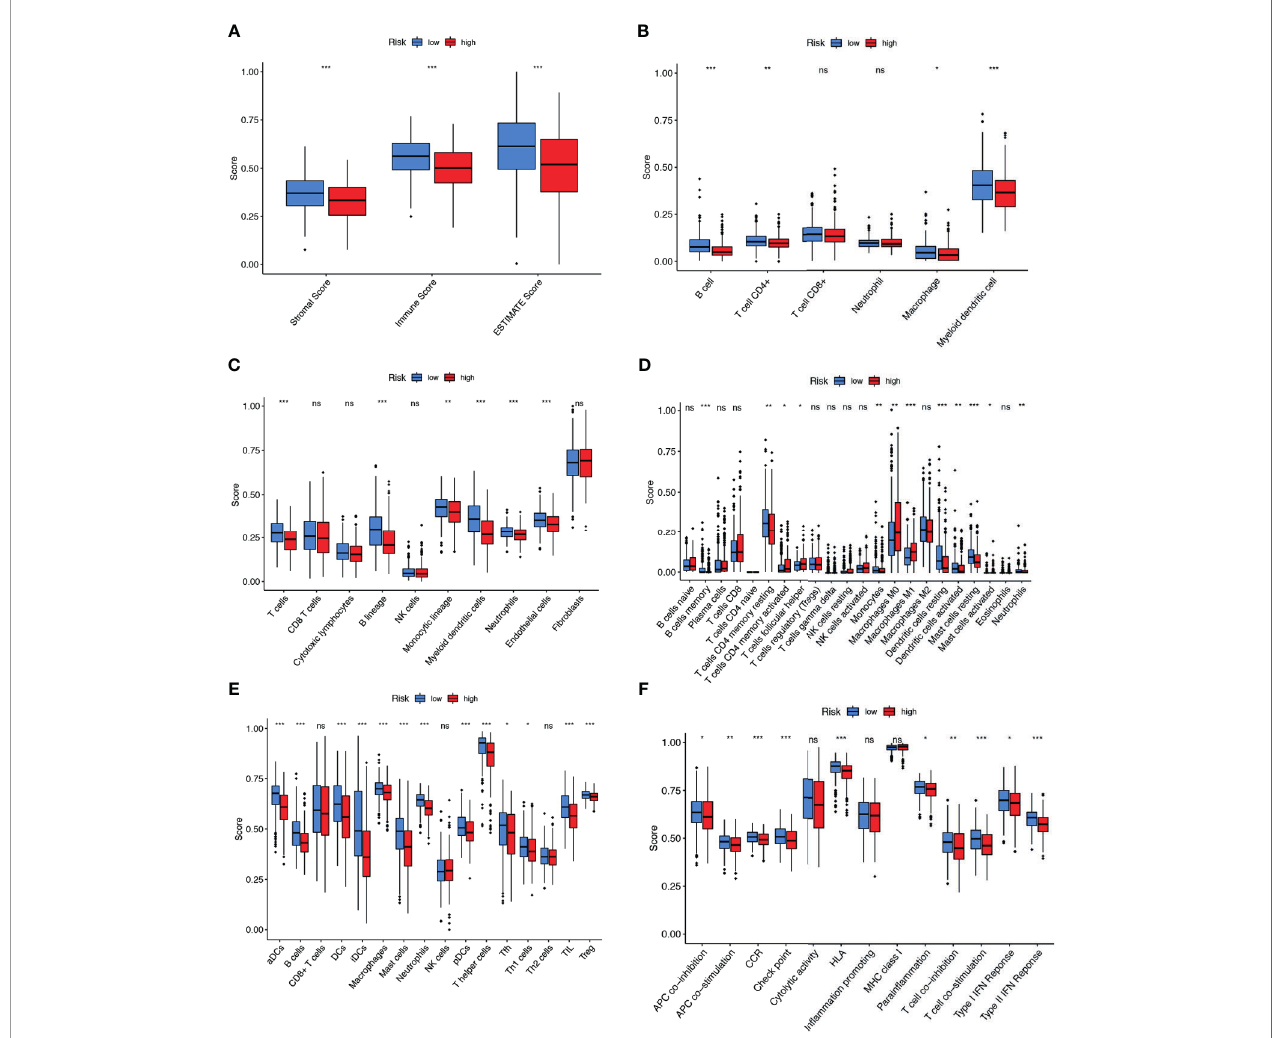
FIGURE 5 | Comparison of the immunity analysis between different risk groups. (A – F) indicates the ESTIMATE, TIMER, MCP counter, CIBERSORTx, and single- sample gene set enrichment analysis (ssGSEA) algorithms to compare the cellular components or cell immune responses between two groups. CCR, cytokine- cytokine receptor. Adjusted P values were showed as: ns, not signi fi cant; *P < 0.05; **P < 0.01; ***P <